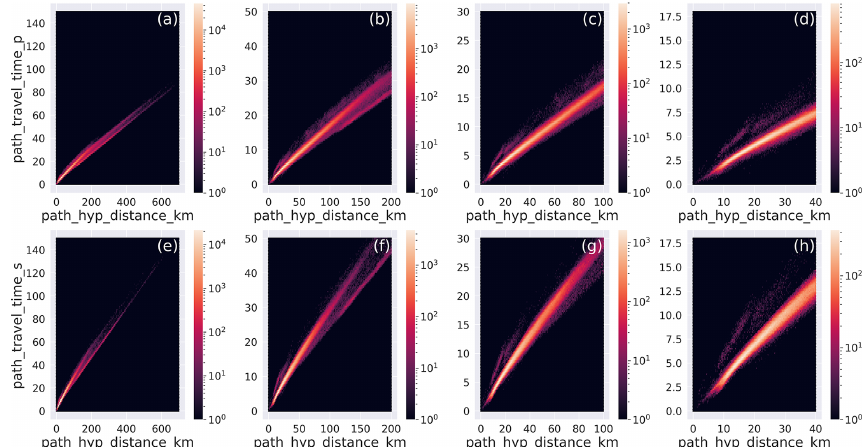
Figure 7. Hexbin plot of the traveltimes for different hypocentral distance ranges for P (a–d) and S waves (e–h) : (a, e) 0–700km; (b, f)